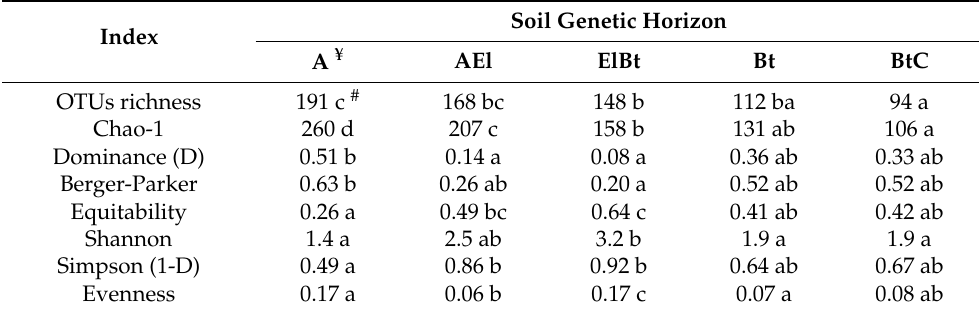
Table 3. Fungal OTU biodiversity indices of the Phaeozem genetic horizons under undisturbed birch forest